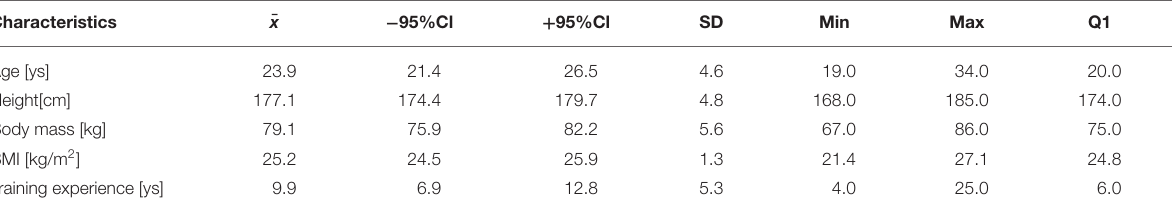
TABLE 1 | Characteristics of the study group.